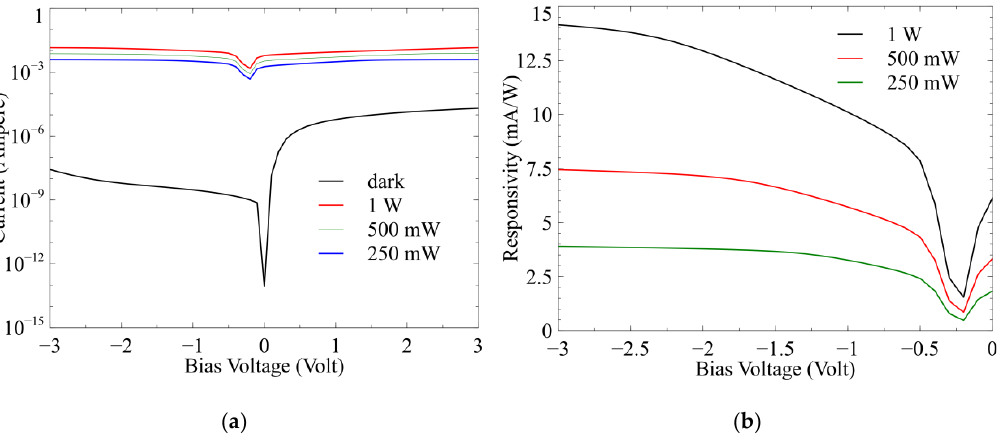
Figure 6. Electrical characteristic of Si grating structure at 850 nm wavelength. ( a ) Steady-state DC characteristic for dark current and light current with optical source power at 1 watt, 500 mW, and 250 mW. ( b ) Responsivity for reverse bias condition with varying optical source power at 1 watt, 500 mW, and 250 mW.